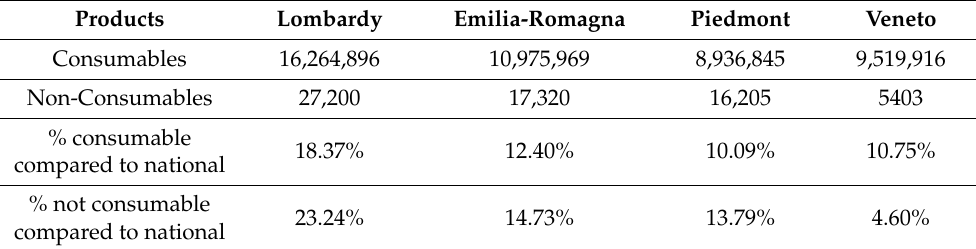
Table 4. Consumable and non-consumable products distributed by Civil Protection.